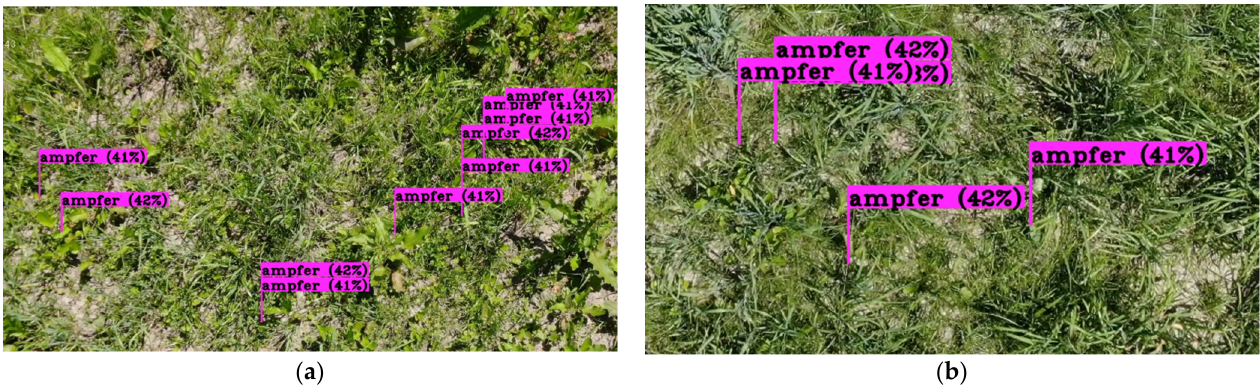
Figure 6. ( a ) Result One after Training One; pink (plant) (germ.); ampfer = broad-leaved dock; ( b ) Result Two, Test One after Training One; pink(plant) (germ.); ampfer = broad-leaved dock.